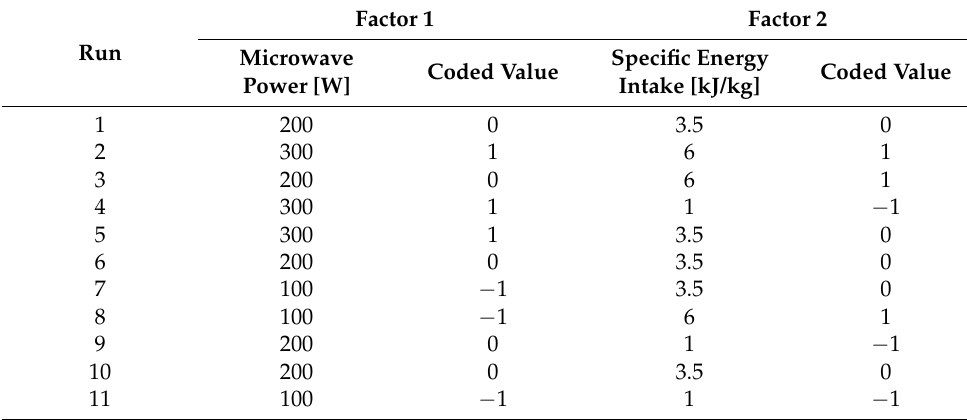
Table 1. Plan of the experiment—actual and coded values of both factors. Factor 1 Factor 2 Run Specific Energy Microwave Coded Value Coded Value Intake [kJ/kg] Power [W] 1 200 0 3.5